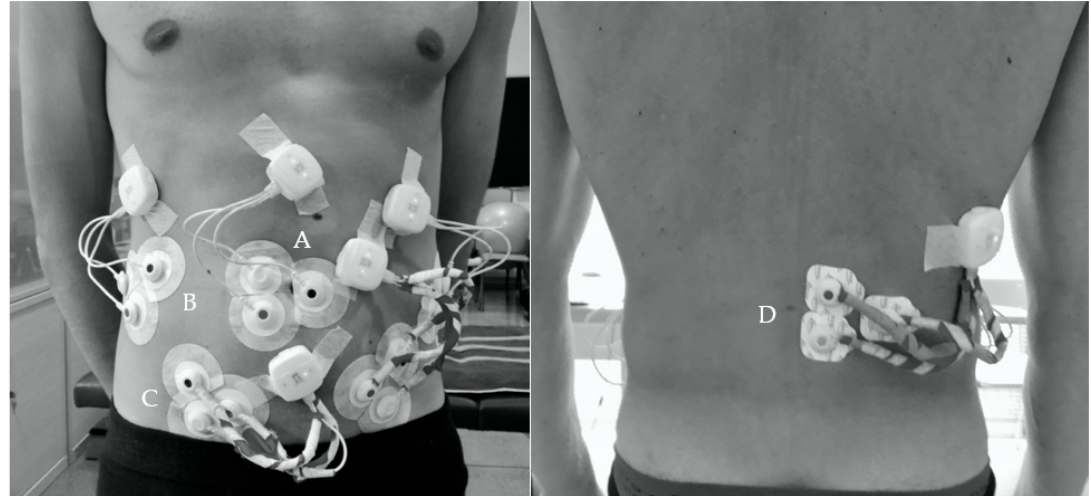
Figure 2. Bipolar surface electromyographic electrode and wireless sensor placement. ( A ) Rectus Abdominis: parallel to the rectus abdominis muscle fibers and approximately located 3 cm lateral and across from the umbilicus over the muscle belly. ( B ) External Oblique: parallel to the external oblique muscle fibers and approximately located 15 cm lateral and across from the umbilicus. ( C ) Internal Oblique: parallel to the internal oblique muscle fibers and halfway between the anterior superior iliac spine of the pelvis and the midline, just superior to the inguinal ligament. ( D ) Erector Spinae: approximately 3 cm from the L3 spinous process, over the muscle belly and parallel to the erector spinae muscle fibers.